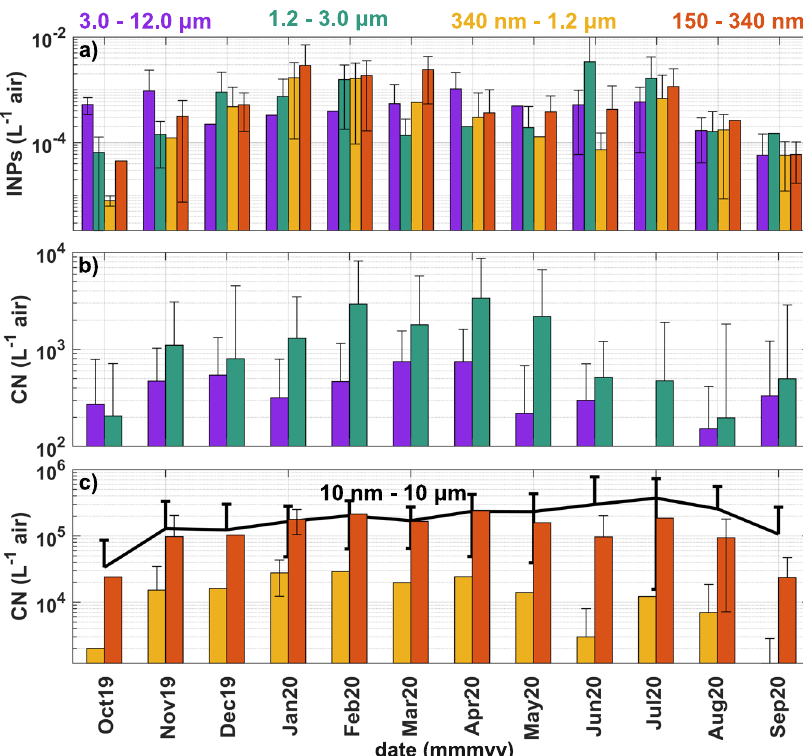
Fig. 5 Seasonal cycle of size-resolved total aerosol and ice nucleating particles (INPs) active at − 20 °C. a Average cumulative INP concentration per month for particles in the size ranges of 3.0 – 12 µ m, 1.2 – 3.0 µ m, 340 nm – 1.2 µ m, and 150 – 340 nm. Monthly averaged total aerosol number concentrations (CN) for b coarse aerosols (3.0 – 12 µ m and 1.2 – 3.0 µ m) and c smaller fractions (340 nm – 1.2 µ m and 150 – 340 nm). Also shown in c is the total aerosol number concentration from 10 nm to 10 µ m averaged per month. INPs are shown at – 20 °C as opposed to warmer temperatures since INPs were active starting at this freezing temperature for most of the year thus to enable an intra-monthly comparison possible (see Fig. 4). Error bars represent standard